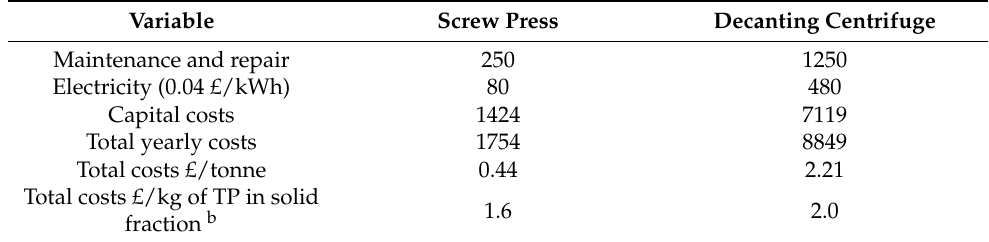
Table 1. Annual costs (£) for treatment of 4000 t of pig slurry by screw press and by